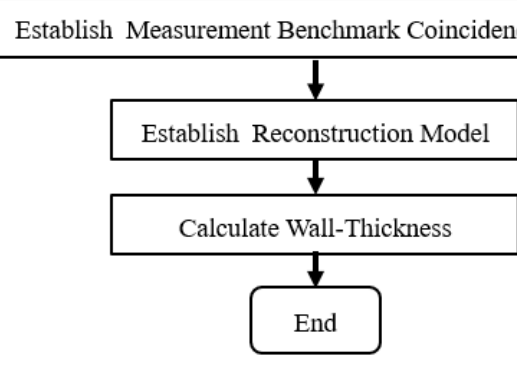
Figure 3. The measurement process.